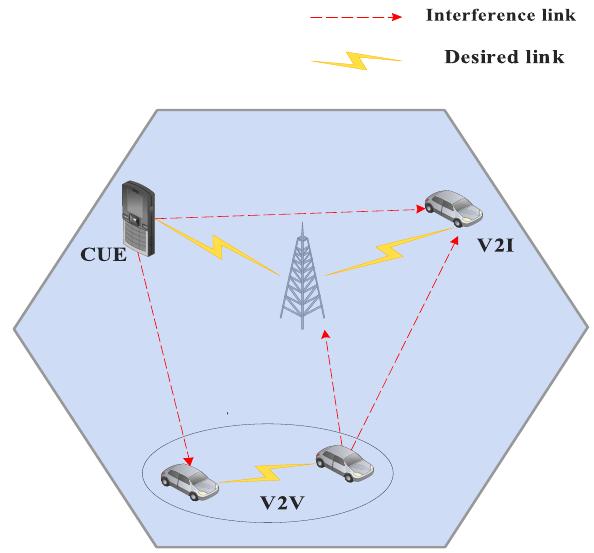
Figure 1. Network architecture. CUE: cellular user equipment; V2I: Vehicle to Infrastructure; V2V: Vehicle to Vehicle.